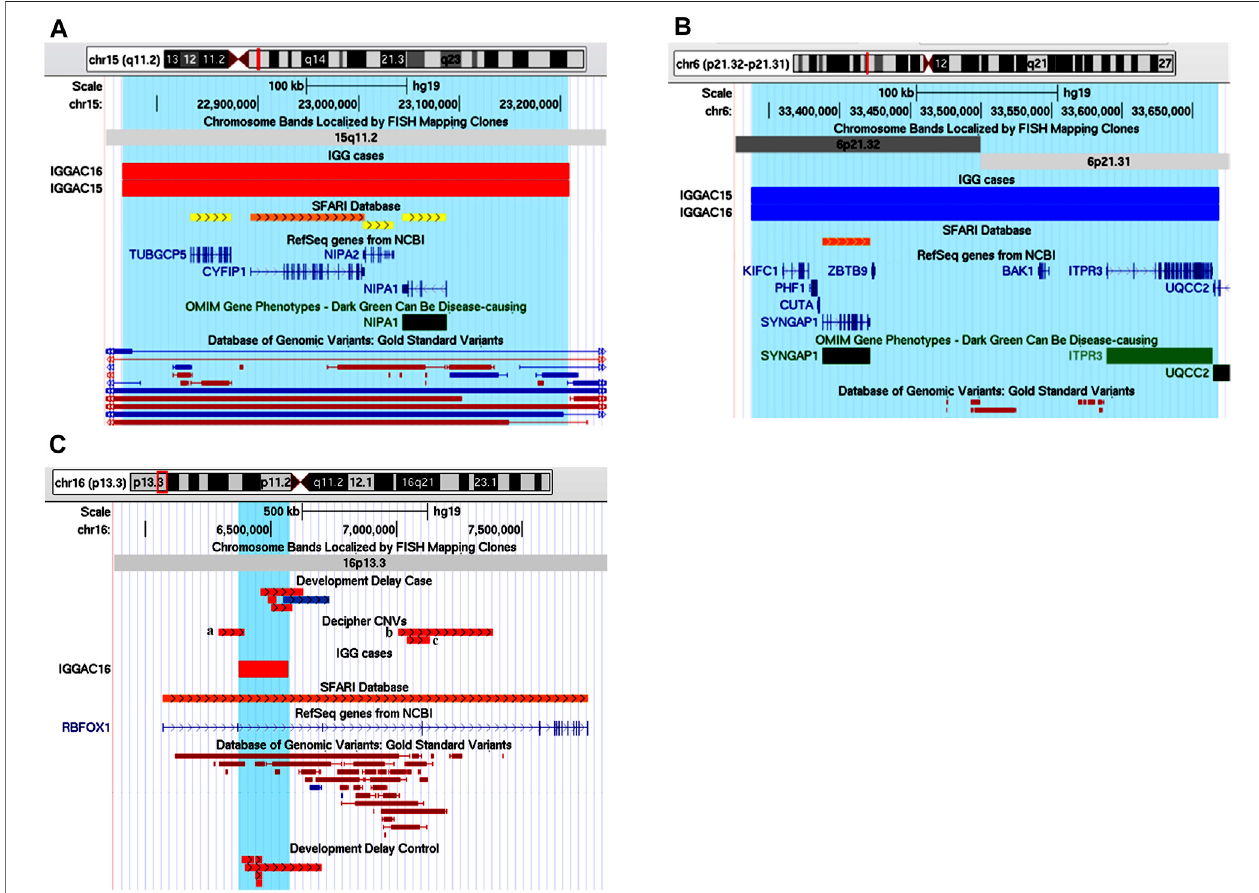
FIGURE3| Additiveeffectsinafamilialcase,siblingsIGGAC15andIGGAC16. (A) Screenshotofchromosome15regionencompassingthedeletionsharedbythe two siblings (red bars, chr15:22,765,628-23,208,901). (B) Screenshot of chromosome 6 region encompassing the duplication shared by the two siblings (blue bars, chr6:33,337,684-33,669,083). (C) Screenshot of chromosome 16 region encompassing the deletion of patient IGGAC16 (red bar, chr16:6,371,455-6,568,176). Deletions reported in Decipher patients (a: patient 283262; b: patient 327250; c: patient